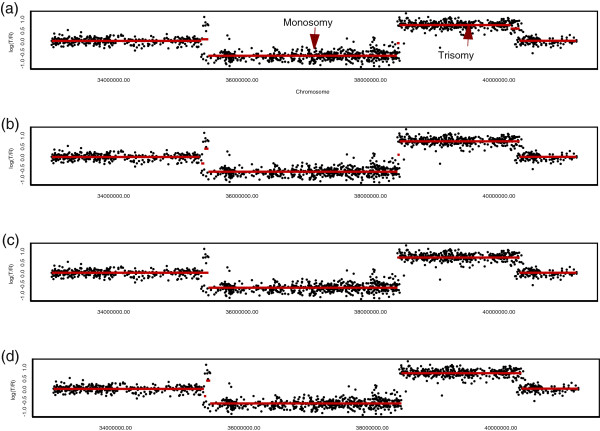
Comparison of the proposed method, circular binary segmentation, CSGseq, and GLAD. The points are based on the combined log2ratios from Memorial Sloan-Kettering Cancer Center and Harvard Medical School. The top panel shows our segments. The last three panels show segments from circular binary segmentation, CSGseq, and GLAD. The red lines indicate the mean values among the probes in segments.